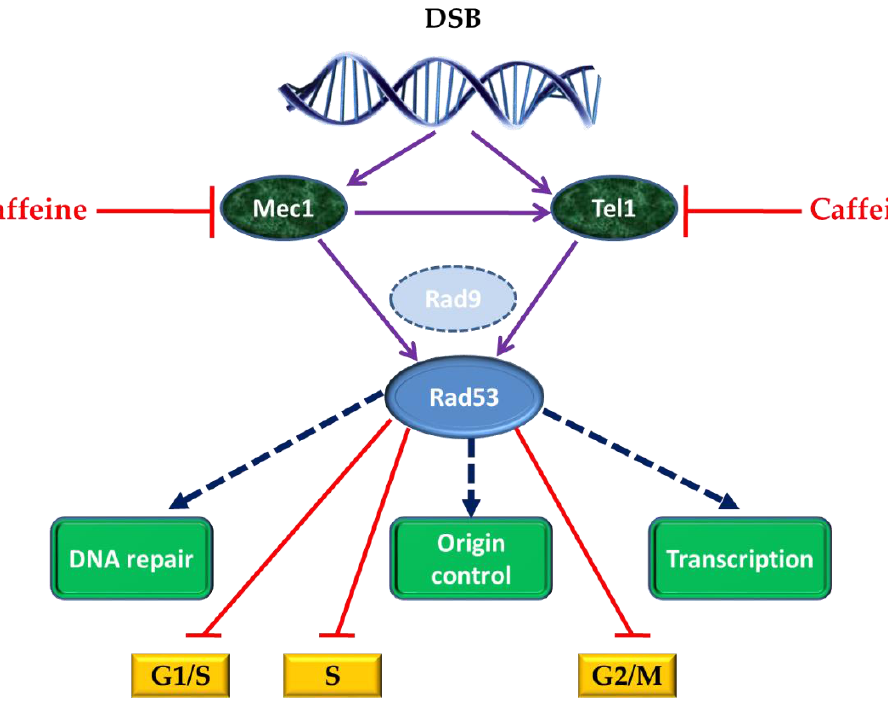
Figure 2. Activation of effector kinases by DNA damage in Saccharomyces cerevisiae cells. The central components are two redundant kinases: Mec1 (Mitosis entry checkpoint 1; ATR in mammals) and Tel1. (Telomere maintenance 1; ATM in mammals). Mec1 is hyperactivated in response to different DNA injuries and is essential for cell viability; Tel1 is activated primarily by double-strand breaks (DSBs), and its loss is not lethal in yeast. Mec1/Tel1 activate the effector kinase Rad53. In G2 phase, Rad53 activation is mediated by Rad9, in response to DNA damage. Crosstalk between Mec1 and Tel1 can occur if stalled replication forks collapse since they can generate DSBs. Rad53 inhibits G1/S, Sphase and G2/M cell cycle transitions. Adapted after [51,52].